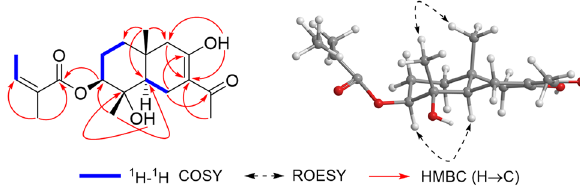
OPP Farnesyl diphosphate (FPP) Scheme 1 Plausible biosynthetic pathway of 1